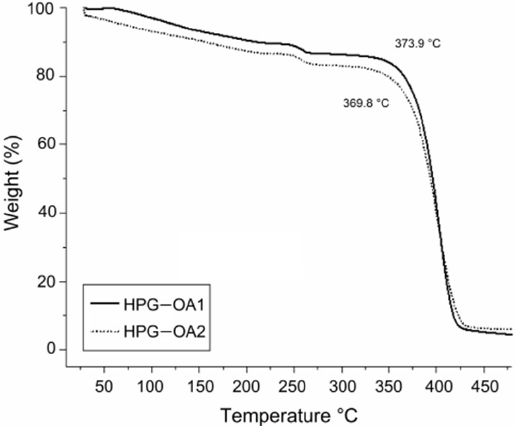
Figure 6. Thermogravimetric curves of HPG-OA1 and HPG-OA2.